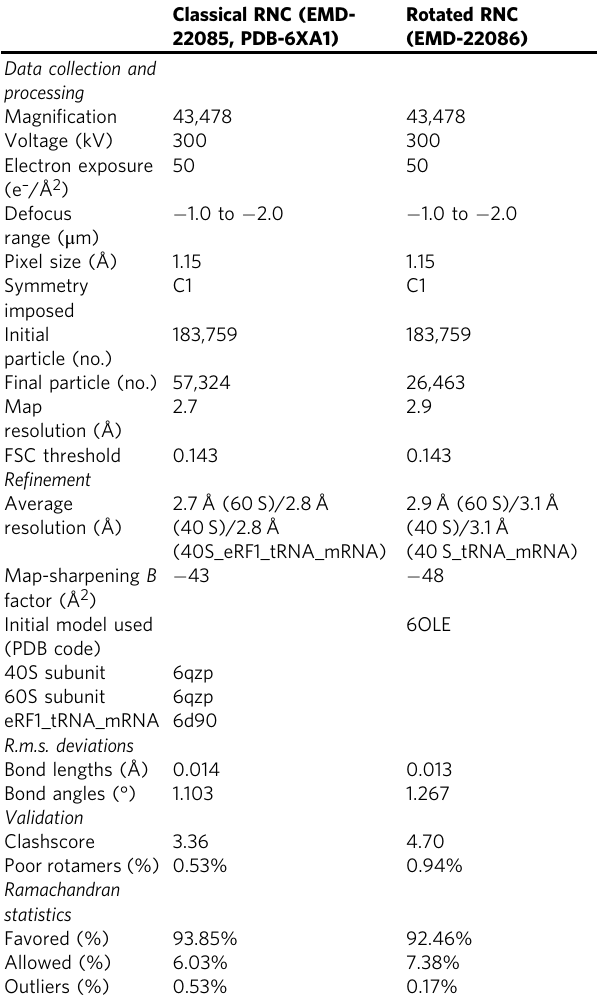
Table 1 Cryo-EM data collection, re fi nement, and validation statistics of PF846-stalled termination